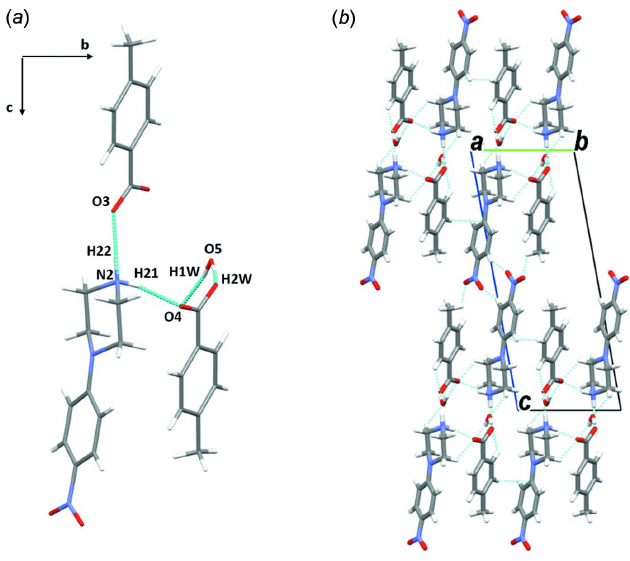
Figure 9 ( a ) A general view of the main intermolecular interactions (N—H (cid:2)(cid:2)(cid:2) O and O—H (cid:2)(cid:2)(cid:2) O) in (III) and ( b ) the molecular packing of (III) with hydrogen bonds shown as dashed